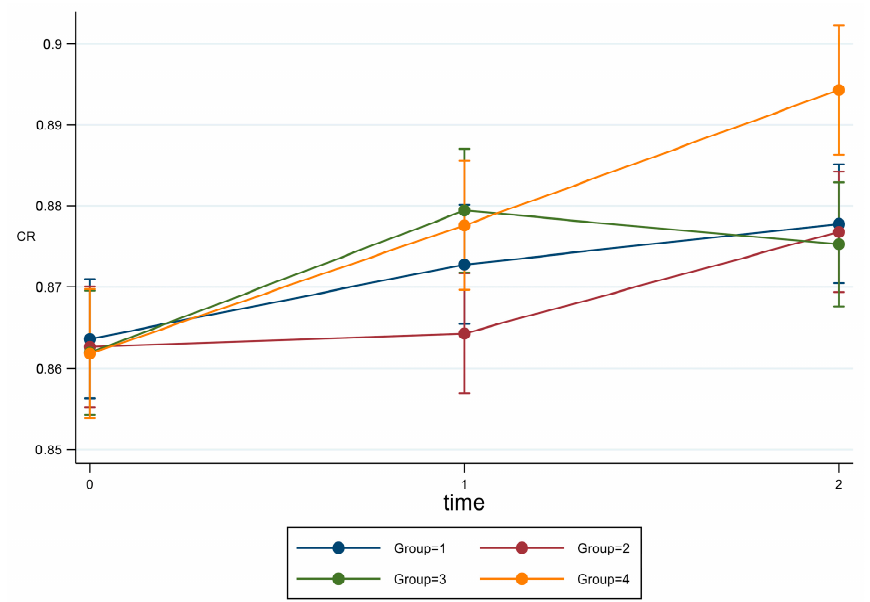
Figure 6. Estimated means and CI 95% from mixed model adjusted for baseline for parameter CR.